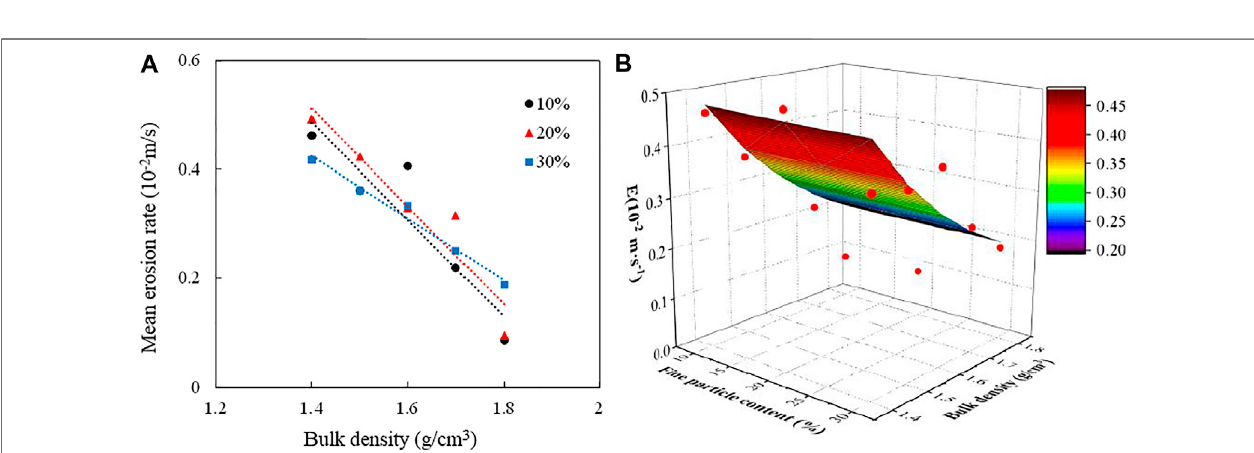
FIGURE11| Relationshipoftheerosionratewithbulkdensityand fi neparticlecontent: (A) relationshipbetweenaverageerosionrateandbulkdensitywithdifferent values of fi ne particle content, and (B) multivariate nonlinear regression curve.